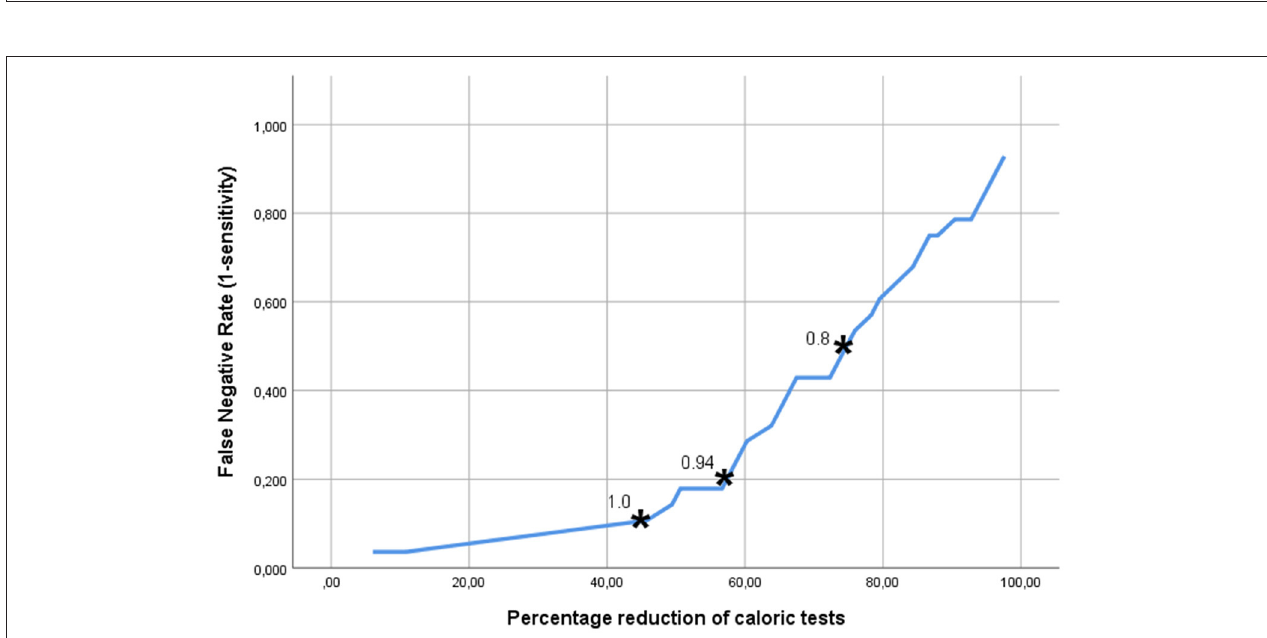
FIGURE 3 | The trade-off between the accepted fraction of CI-candidates requiring caloric testing, but not undergoing it, and the reduction in the number of the caloric tests, which can be achieved if the MGS (minimal gain & saccades) is used as discriminating parameter. The asterisks indicate the points on the curve representing the MGS cut-off points 0.8, 0.9, and 1.0. The latter cut-off value, associated with a sensitivity of 90% resulted in a reduction of the number of patients in need of caloric testing by